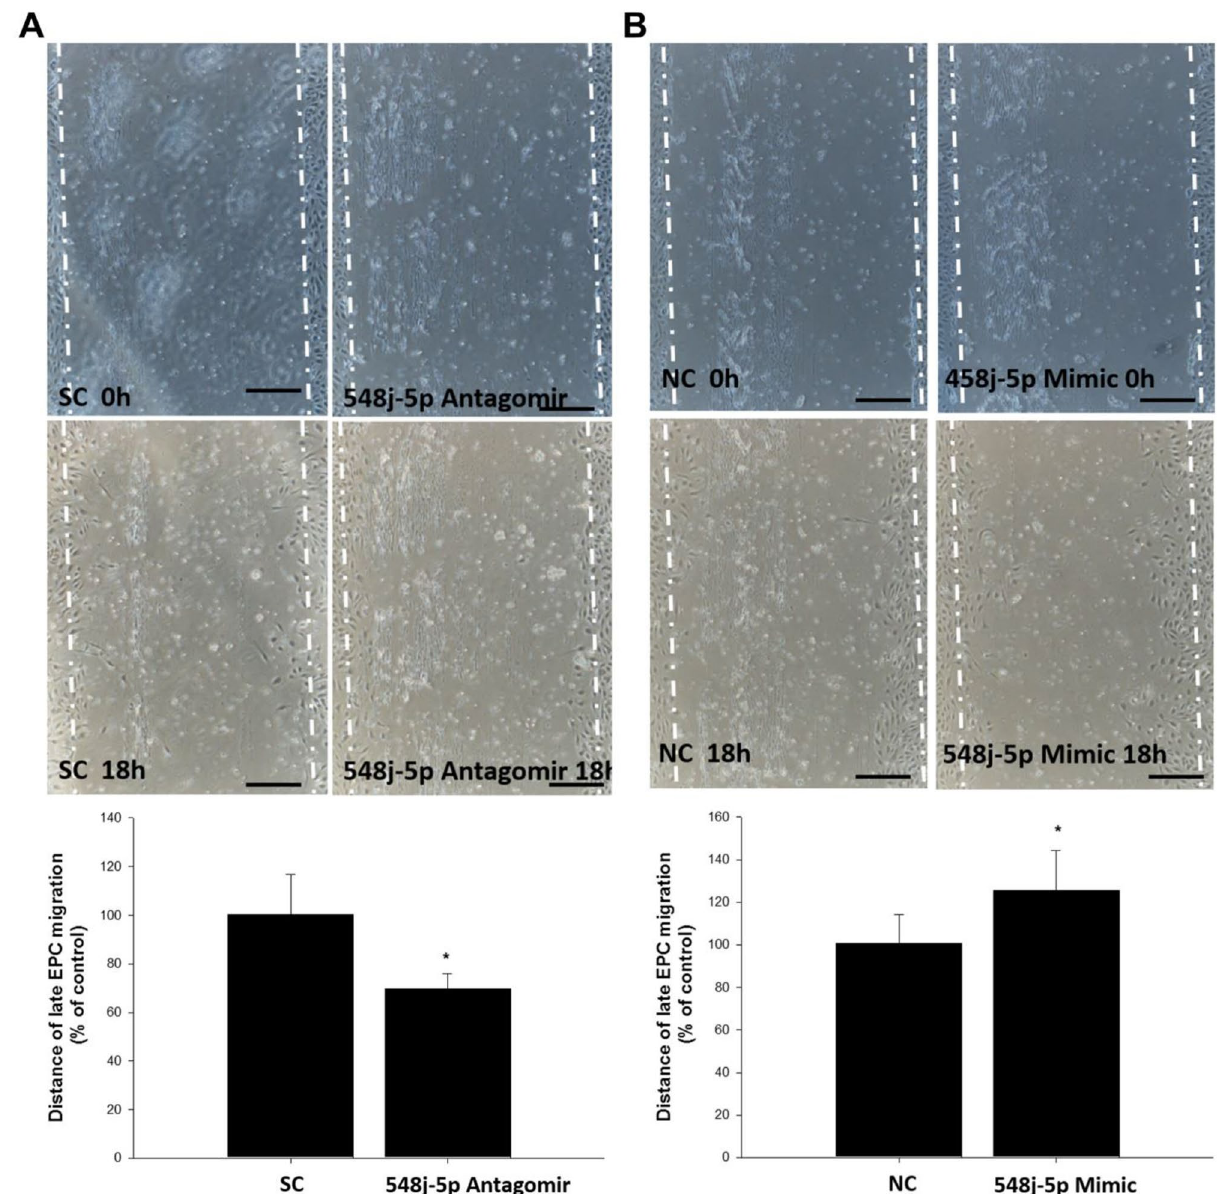
(* P < 0.05 vs. control, n = 6 for each